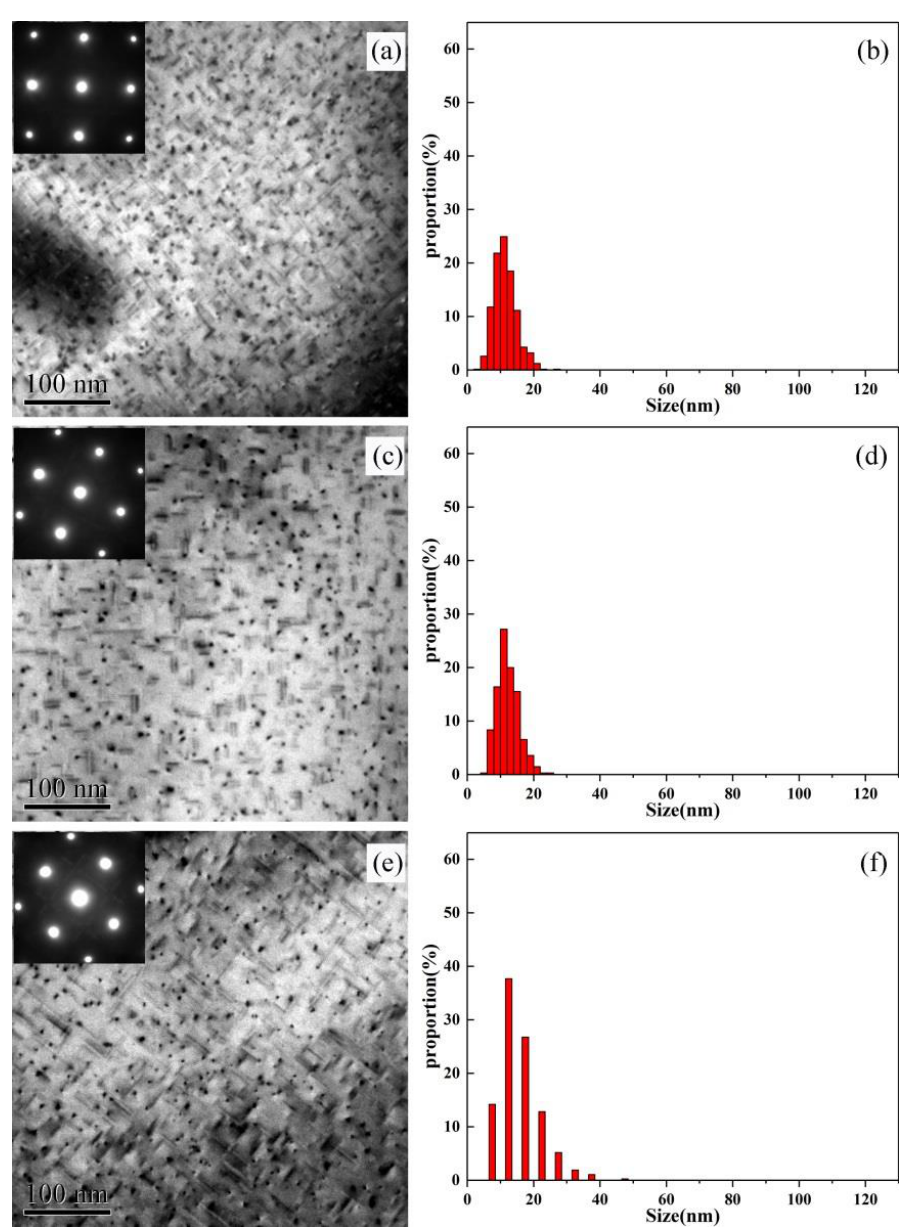
Figure 3. TEM on intragranular precipitates of alloy AZ and the size distribution of needle phase under 170 ◦ C aging ( a , b ) under aged state, ( c , d ) peak aged state, and ( e , f ) over aged state. Table 3. Quantitative TEM studies of precipitates in the alloys AA and AZ